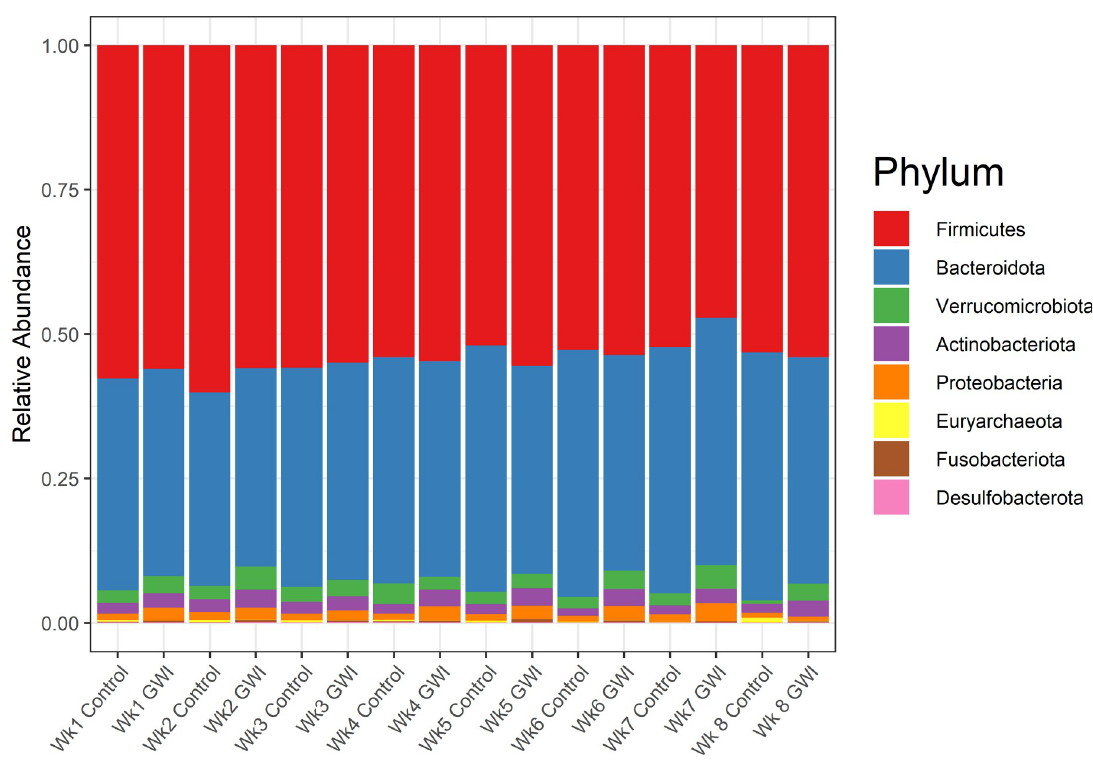
Fig 2. Relative abundance bar plot of the top 8 phyla by aggregated by week and GWI status.